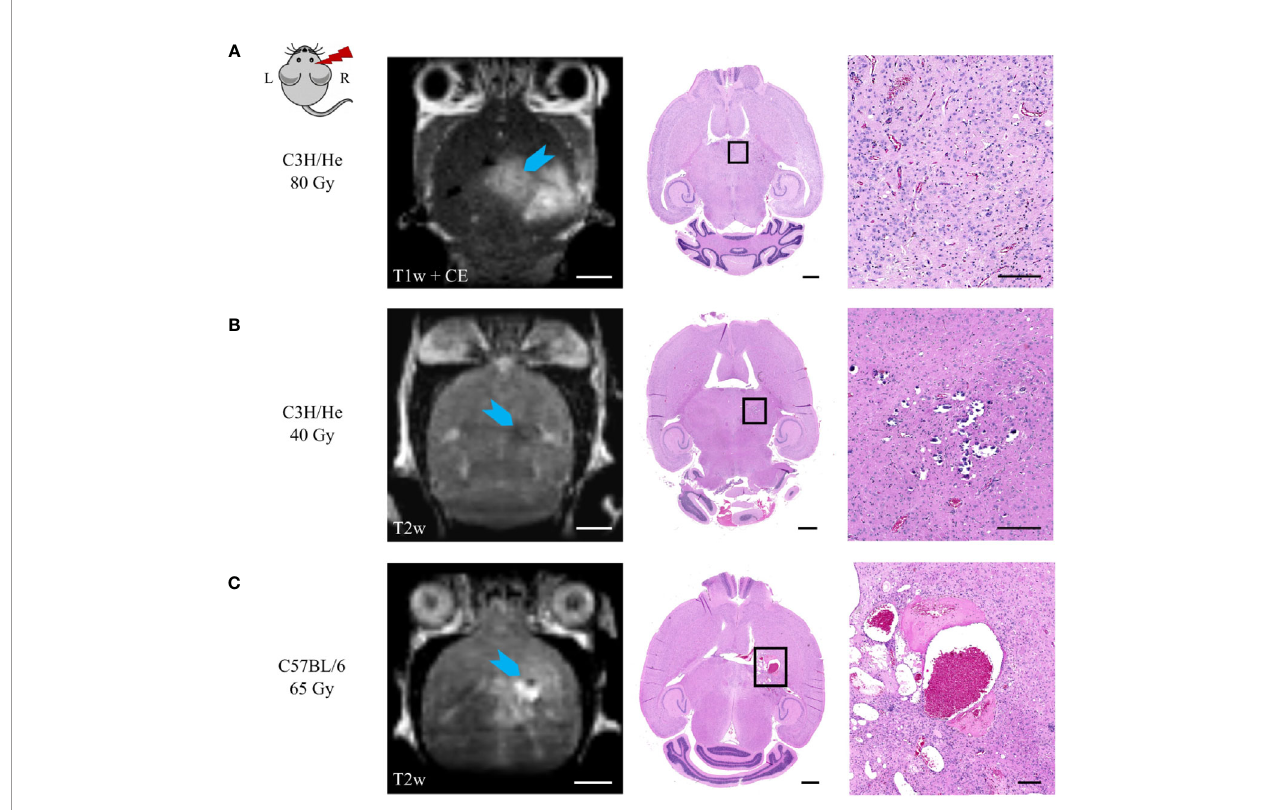
FIGURE 9 | Correlation of MR image data and H&E histology. (A) Angiogenesis and vessel dilatation were observed in regions of contrast agent accumulation in T1w MRI. T2 hypo-intense signal could be related to (B) calci fi cation or (C) fi brin extravasation and haemorrhage. (C) Hyper-intense spots in T2w sequences corresponded to edema and immensely dilated vessels. Scale bars (left to right): 2 mm, 1 mm, 200